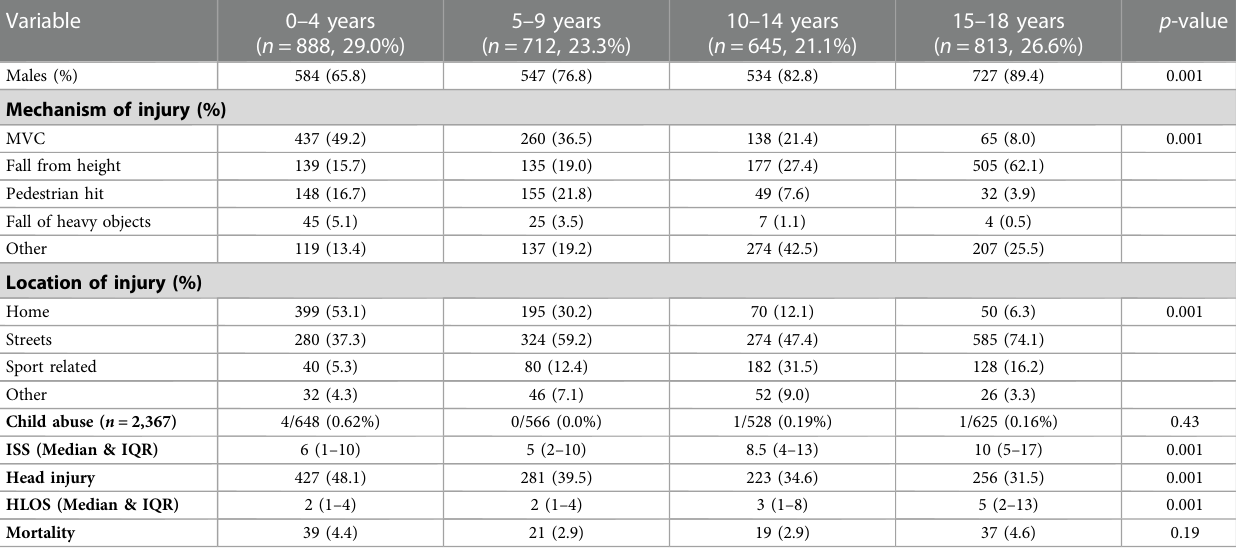
TABLE 2 Characteristics of pediatric trauma patients and outcomes based on the age groups ( N =3,058).